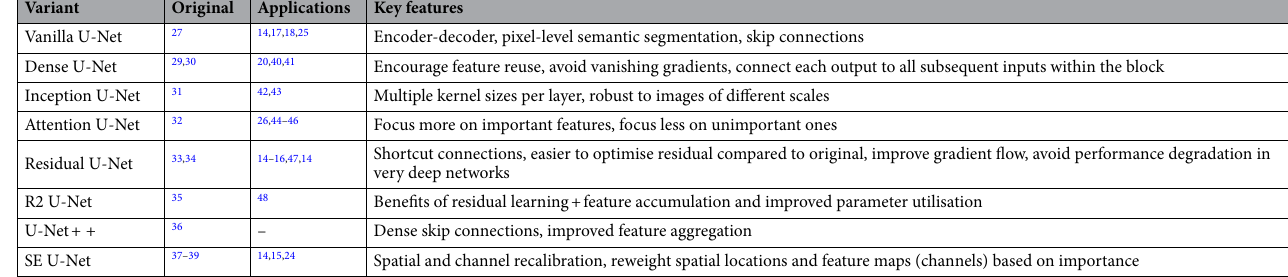
Table 1. Summary of the U-Net architectures compared in this